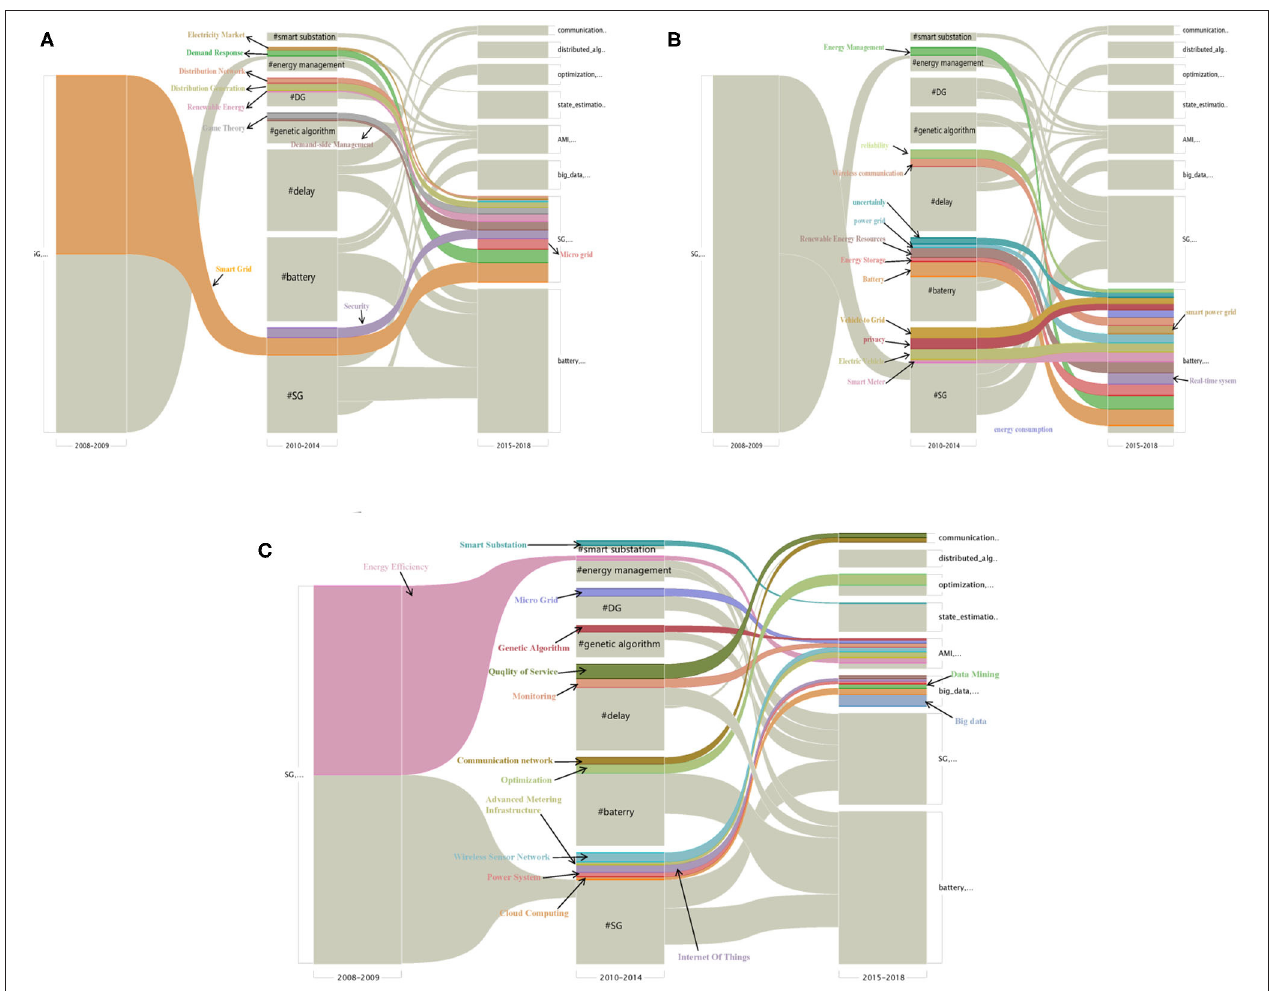
FIGURE 11 | The alluvial diagram of author-keywords in three stages. Significance clustering in 2008–2009, 2010–2014, and 2015–2018 takes up a column in the figure. Each block in a column represents a cluster, and the height of the block reflects the keywords flow for that cluster. Darker color was used to indicate the significant subset of each cluster. All keywords that are clustered in the subset of others in 2015–2018 are colored to highlight the fusion and formation of clusters. (A) Flow of keywords in SG clustering. (B) Flow of keywords in battery clustering. (C) Flow of keywords in other